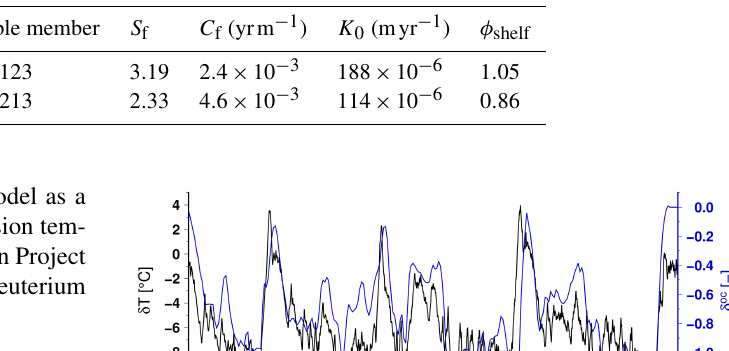
Table 3. Parameter values for the ensemble members that yield the lowest RMSE with respect to observations at the end of the 100kyr simulation under perpetual present-day climate forcing.